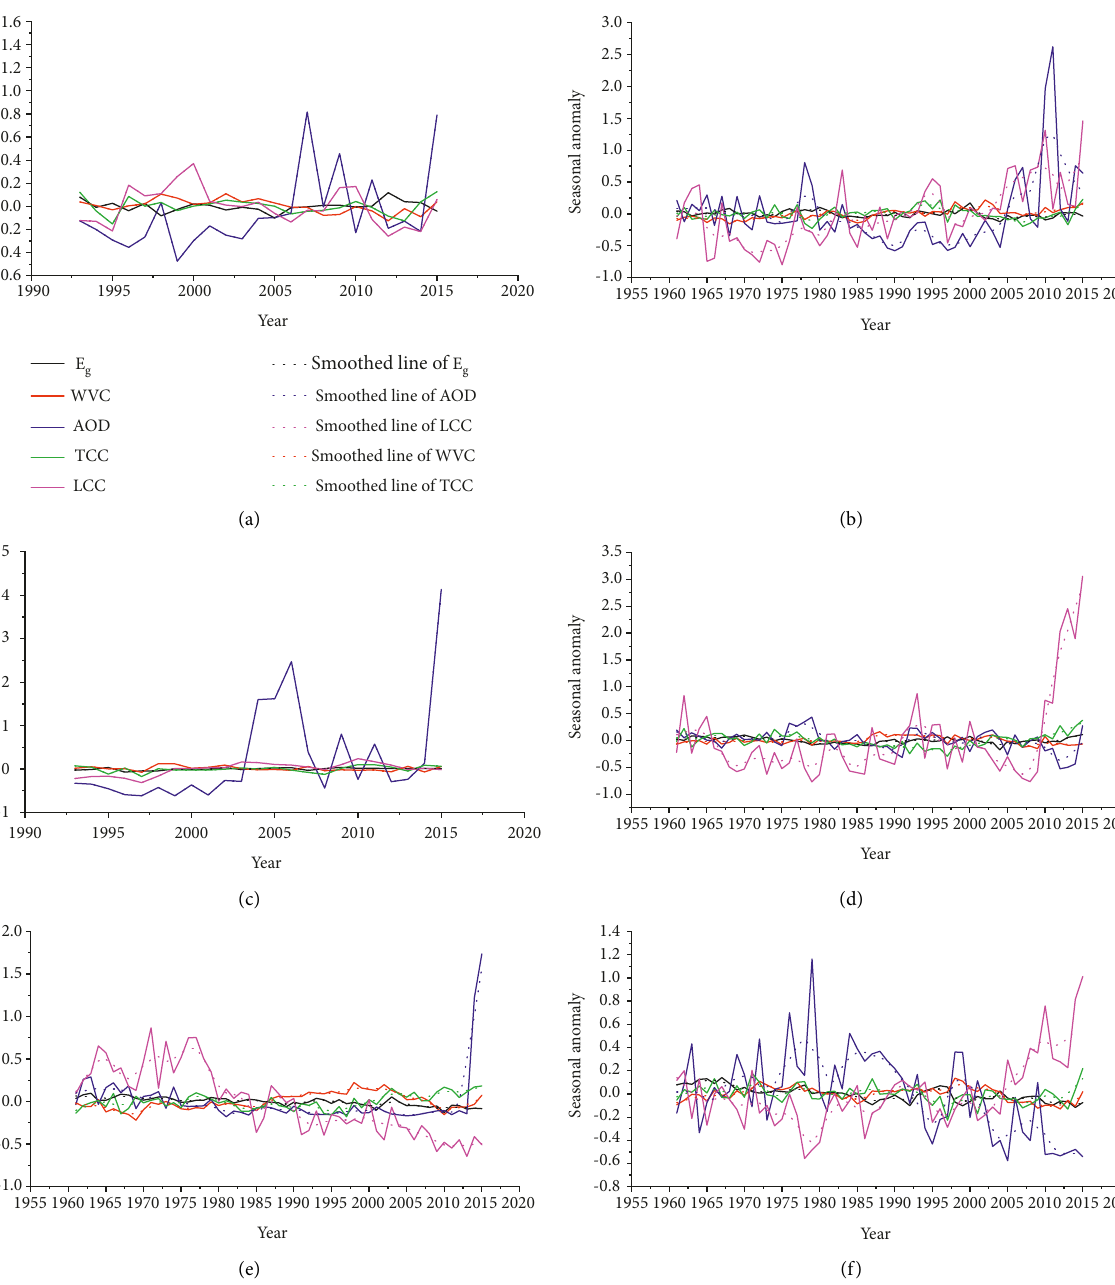
g (black solid lines), WVC (red solid lines), and AOD (blue solid lines) smoothed by the